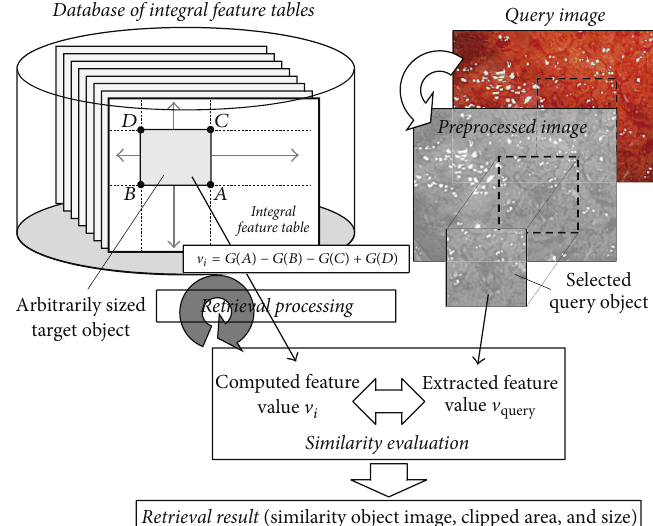
Figure 6: Illustration of the proposed retrieval method using the integral feature table.